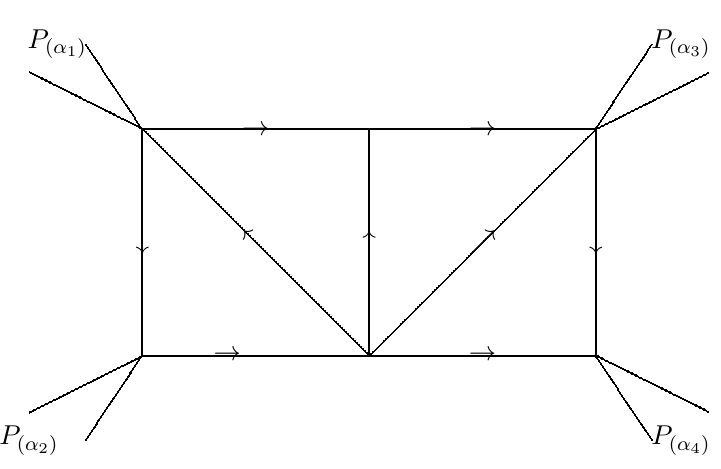
Figure 3 . Example of a reduced diagram. The arrows denote the direction of (cid:13)ow of energy along the on-shell internal propagators. This reduced diagram does not correspond to a pinch singularity since by following the arrows we can go around a closed loop in the lower left